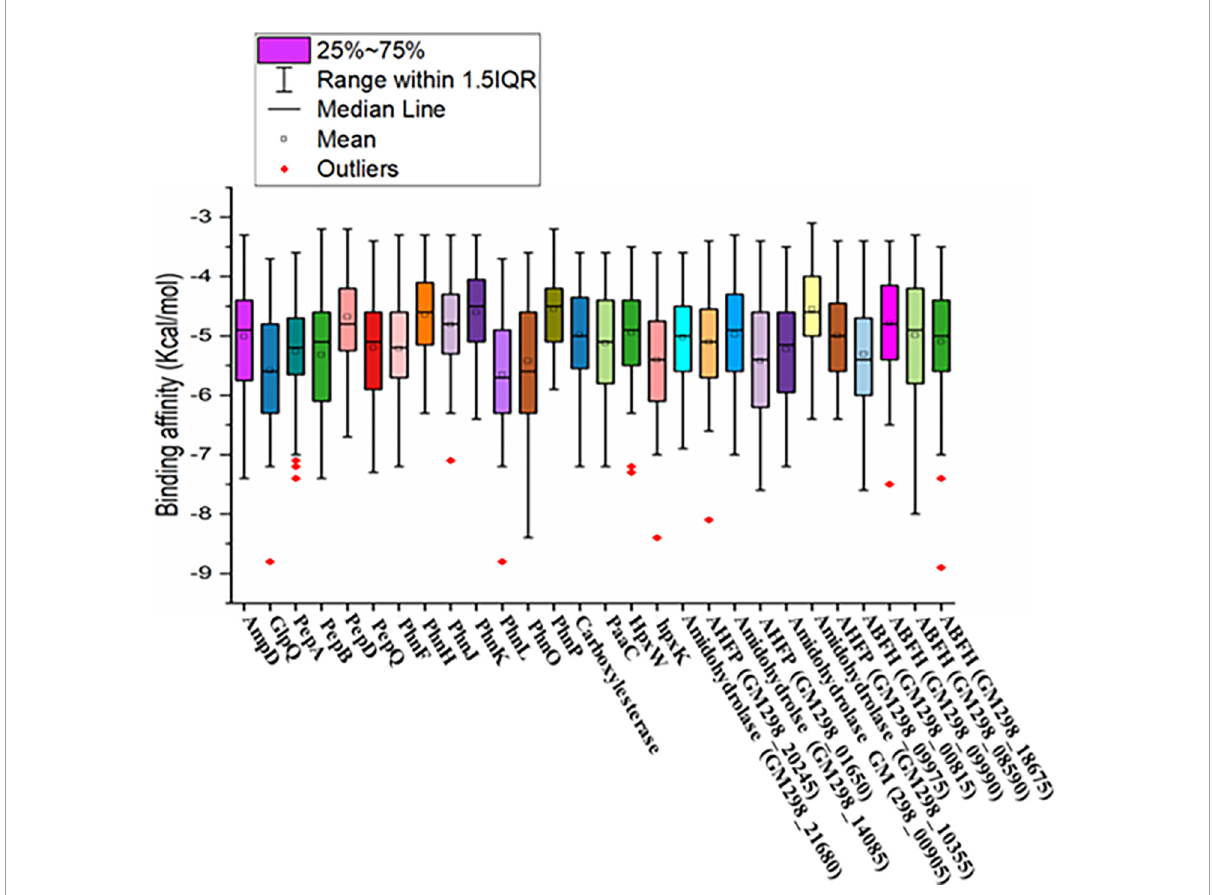
FIGURE5 Graphical representation of virtual screening results of pesticide-degrading validated model proteins with 105 different organophosphorus pesticides and other common pesticides applied in fields.